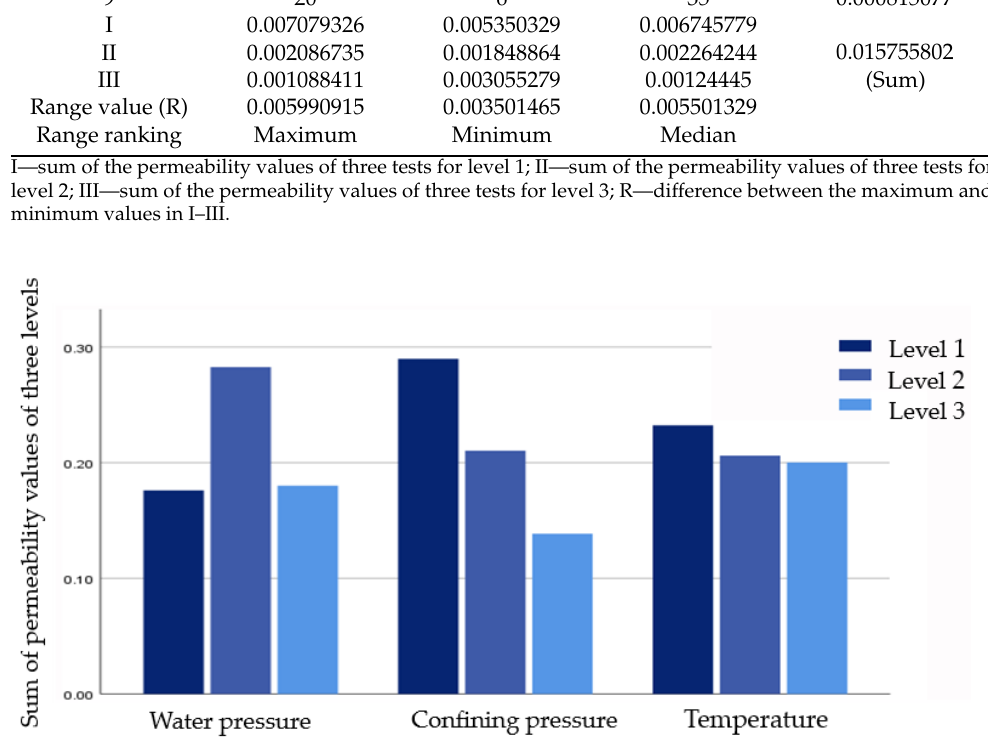
Figure 13. Trend analysis of orthogonal test results for subcategory Ι 2 sandstone.